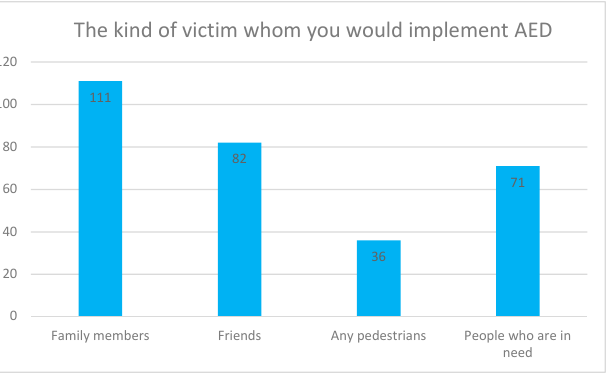
Figure 2. The kind of victim on whom you would implement AED. * The respondents could choose more than one answer for this question.